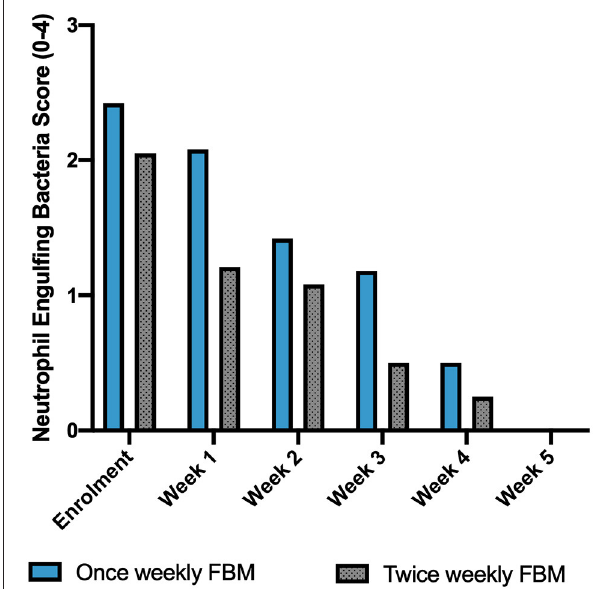
FIGURE 2 | Average Neutrophil Engulfing Bacteria (NES) scores per week of study, in comparison with those reported for twice weekly FBM application from previous published study (